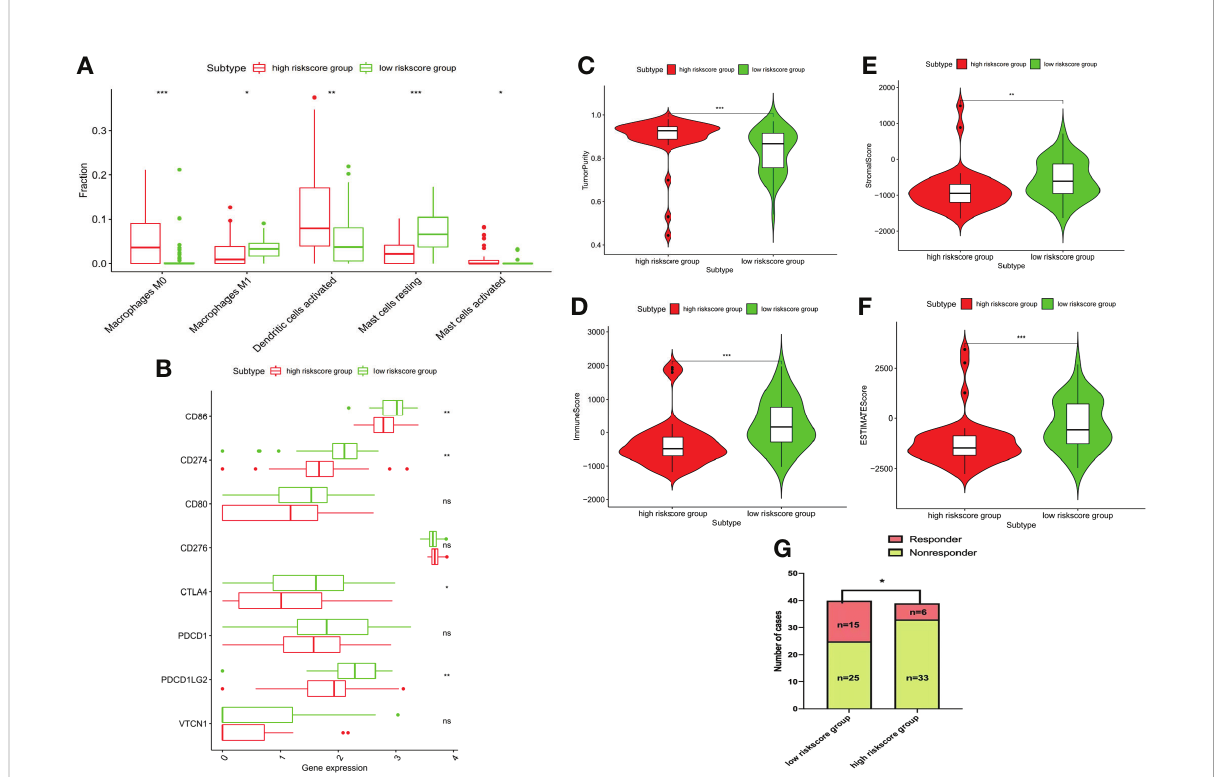
FIGURE 10 Immune characteristics among different risk groups. (A) Bar chart showing the immune in fi ltrating cells that are signi fi cantly different between the two risk groups. (B) Tumor purity. (C) Immune, (D) stromal, and (E) ESTIMATE scores. (F) Bar chart showing the immune checkpoints that are signi fi cantly differentially expressed between the two risk groups. (G) Correlation between risk score and the clinical response to immunotherapy (*P < 0.05, **P < 0.01; ***P < 0.001) ns, no signi fi cant difference.